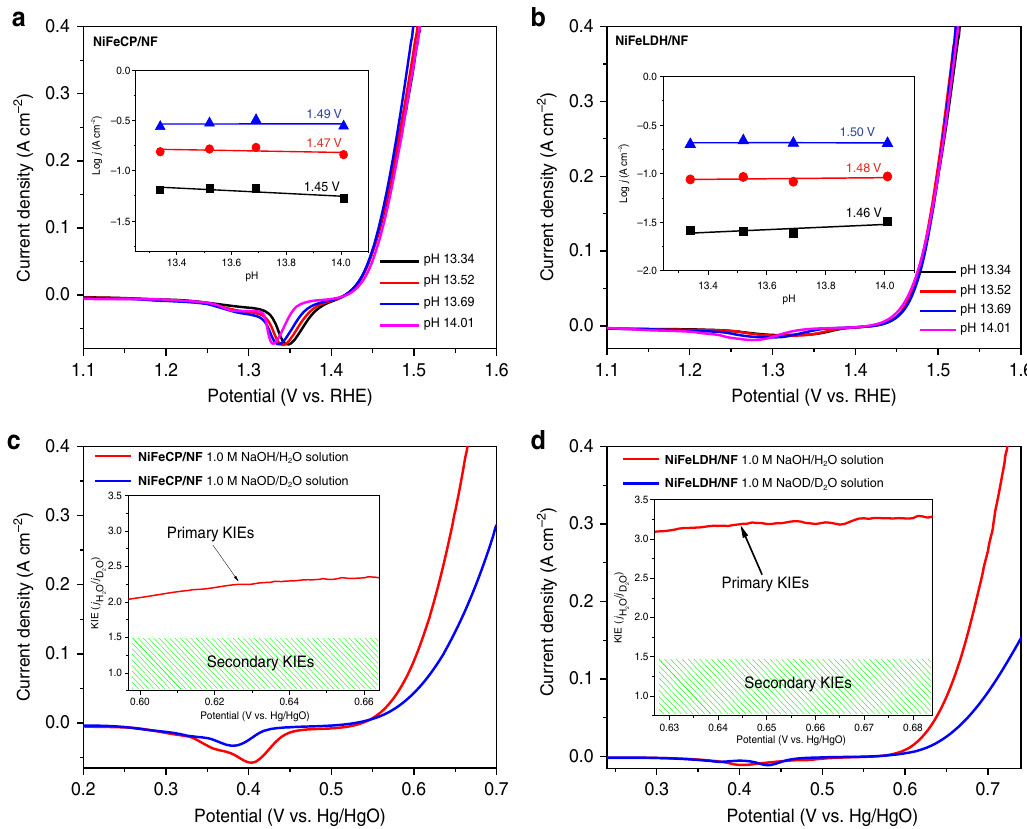
Fig. 6 pH dependence and kinetic isotope effects studies. LSV curves of a NiFeCP/NF and b NiFe LDH/NF in KOH solutions as a function of pH. The inset exhibits the reaction order of pH value. LSV curves of: c NiFeCP/NF and d NiFe LDH/NF in aqueous 1.0 M NaOH solutions and 1.0 M NaOD D 2 O solutions. The insets are the kinetic isotope effect values vs